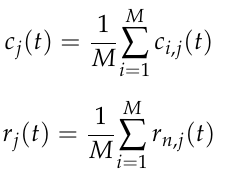
r of is shown in (14). The IMF component is divided into noise and useful signals as per noised signal.